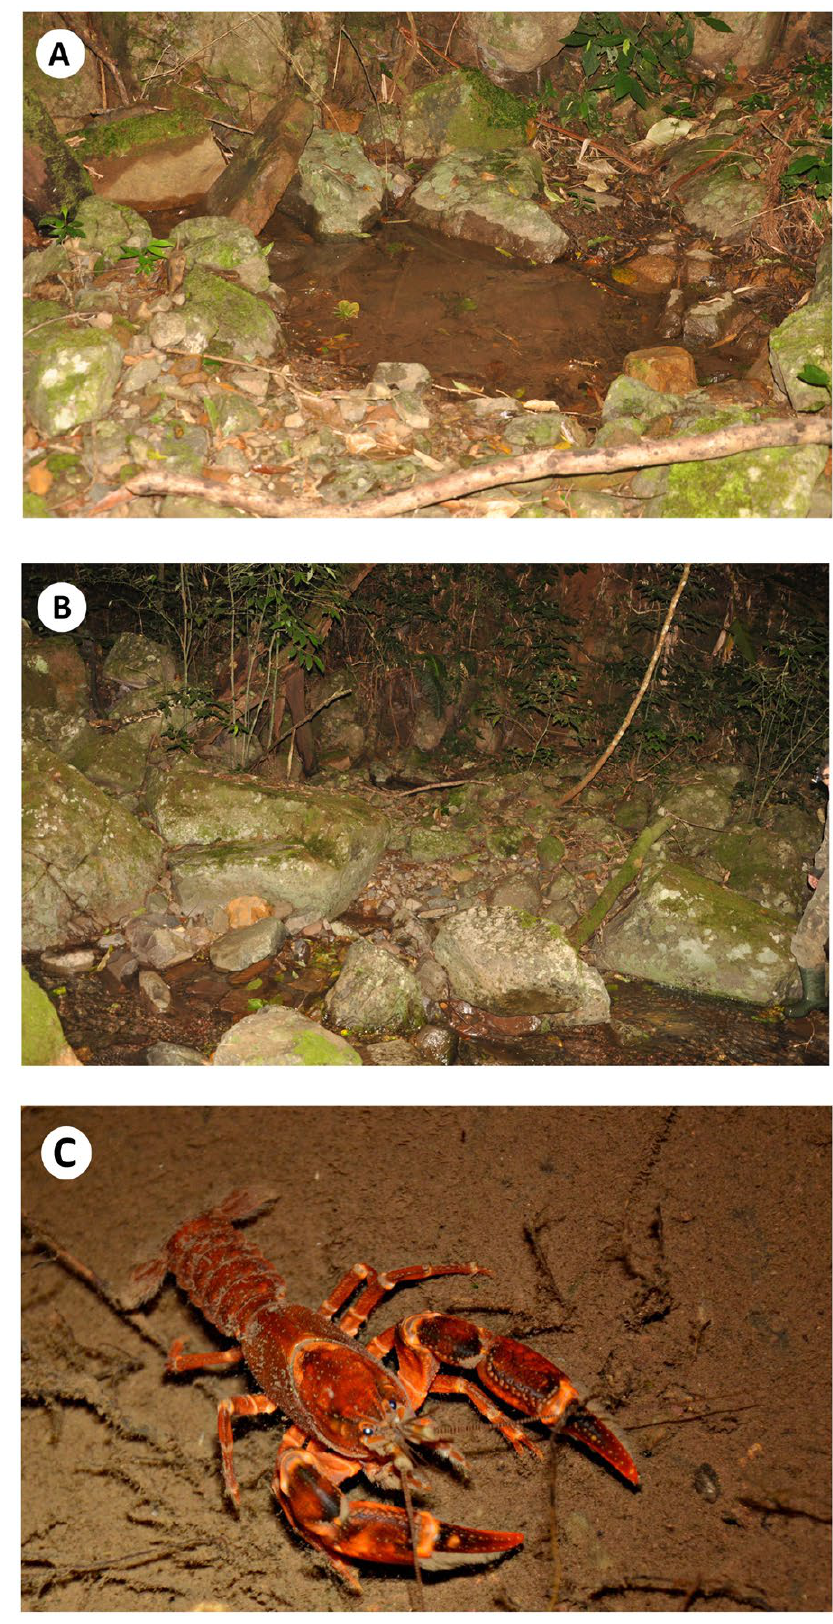
Figure 6. Parastacus pilicarpus sp. nov., habitat and living specimens. A, B, Typical habitat, a first order stream in the municipality of Morro Grande, state of Santa Catarina; C, living specimen. Photographs by Caio R. M. Feltrin. No available information of scale in photograph